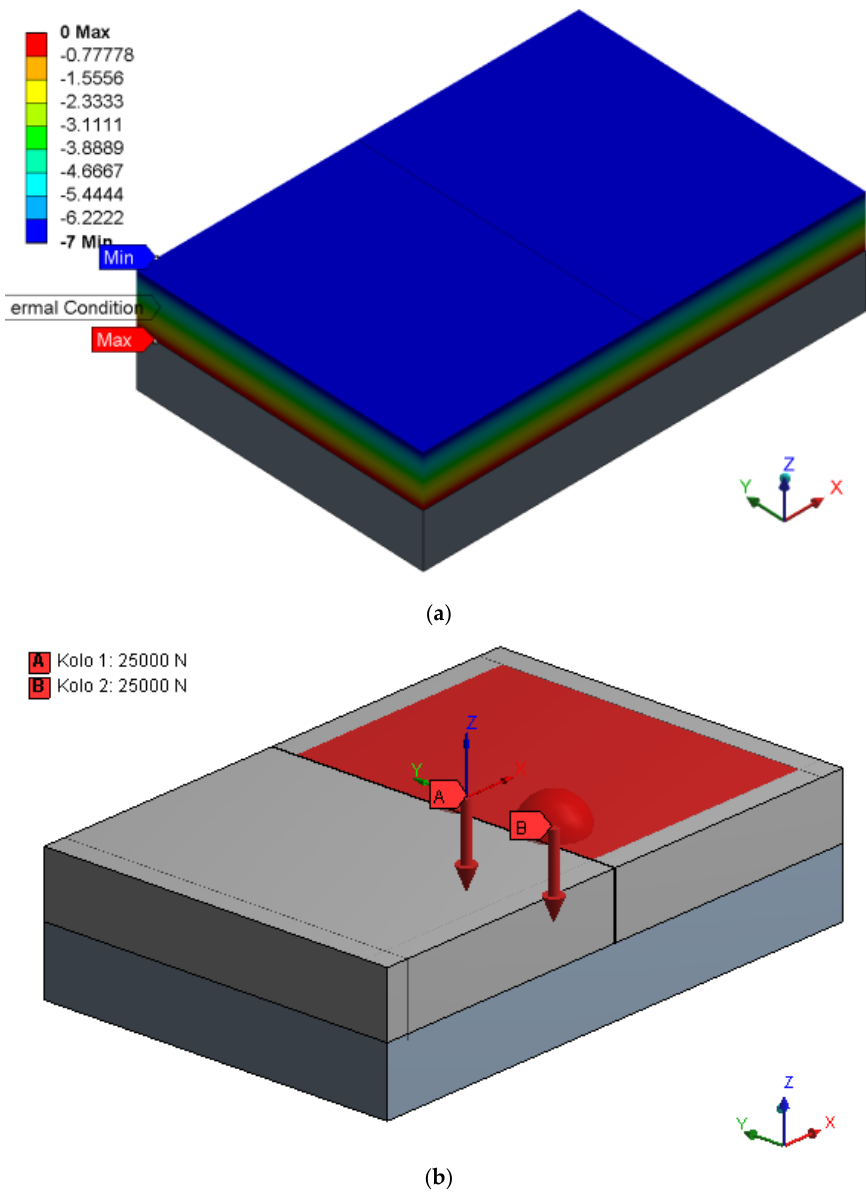
Figure 5. ( a ) Temperature gradient; and ( b ) dual wheel axle on concrete pavement. Spatial models of the pavement allow performing different variants of solutions with the inclusion of dowels in different positions. Non-linear calculations were performed for 17 variants. A certain variant models the precise position of a dowel according to the project design. Another variant models the missing dowel. Six variants model different vertical translations of dowels. Another six variants model different vertical tilts of dowels. Three variants model different longitudinal translations of dowels. Each of the variants of defective dowels was described by a calculation: